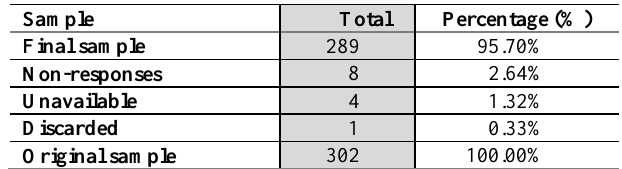
Table 1: Response from the questionnaires